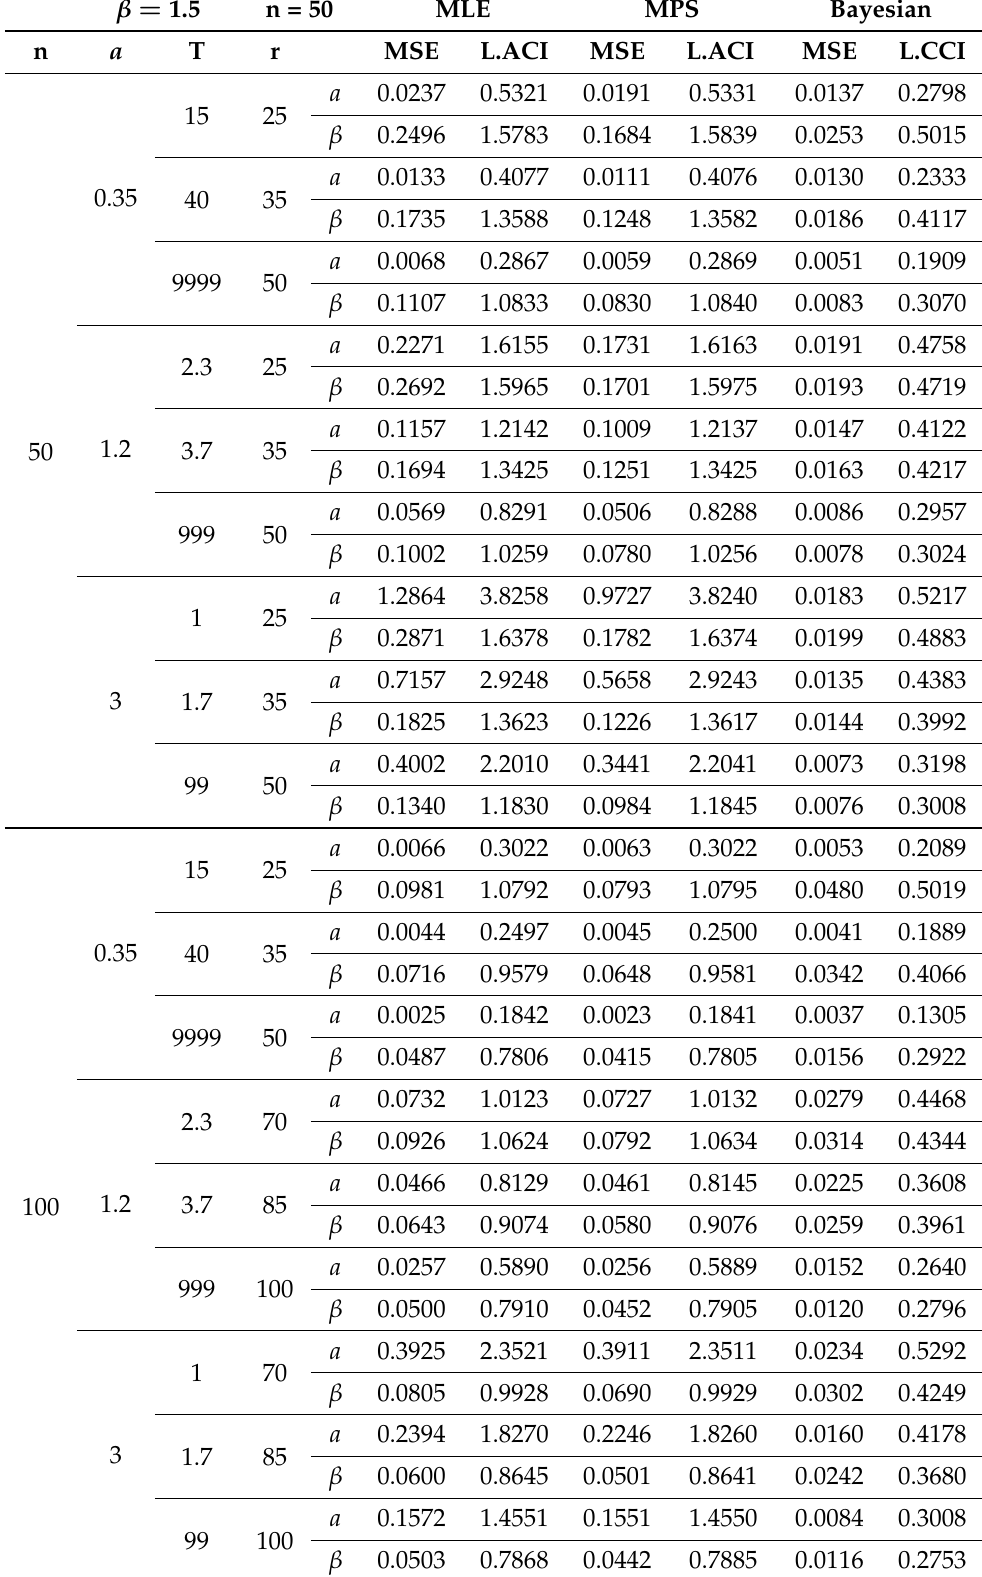
Table 4. MSE and length of CI for MLE, MPS, and Bayesian estimation for parameter of the TCP-ITL based on hybrid censored samples: when β =